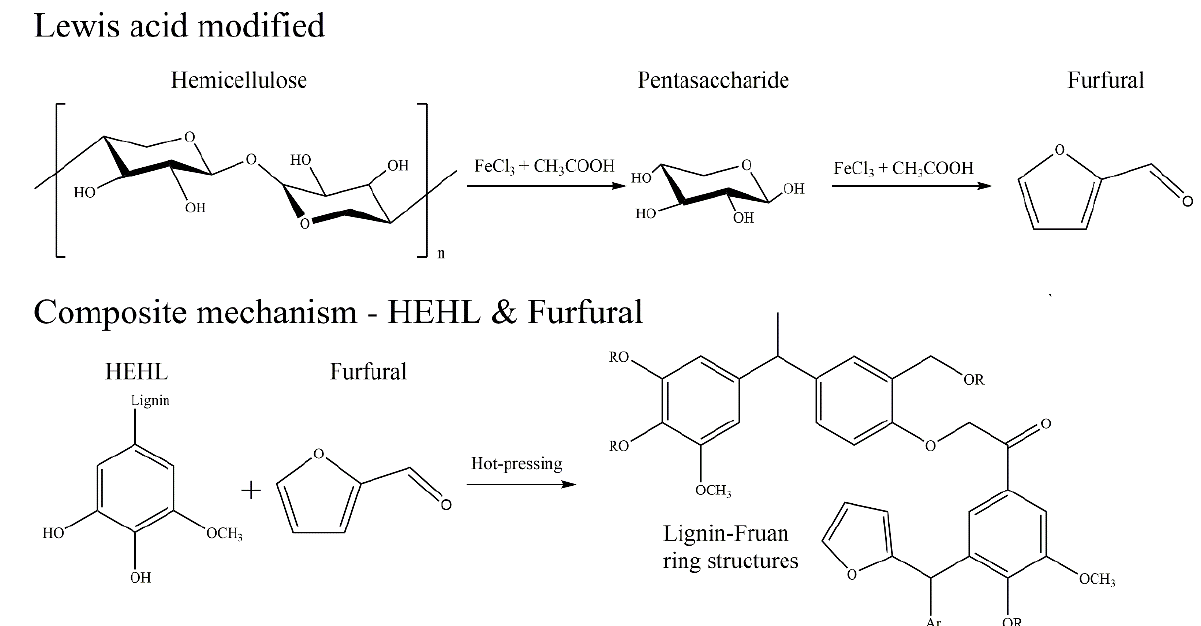
Figure 12. Reaction mechanisms that improve the mechanical properties of MFPs.